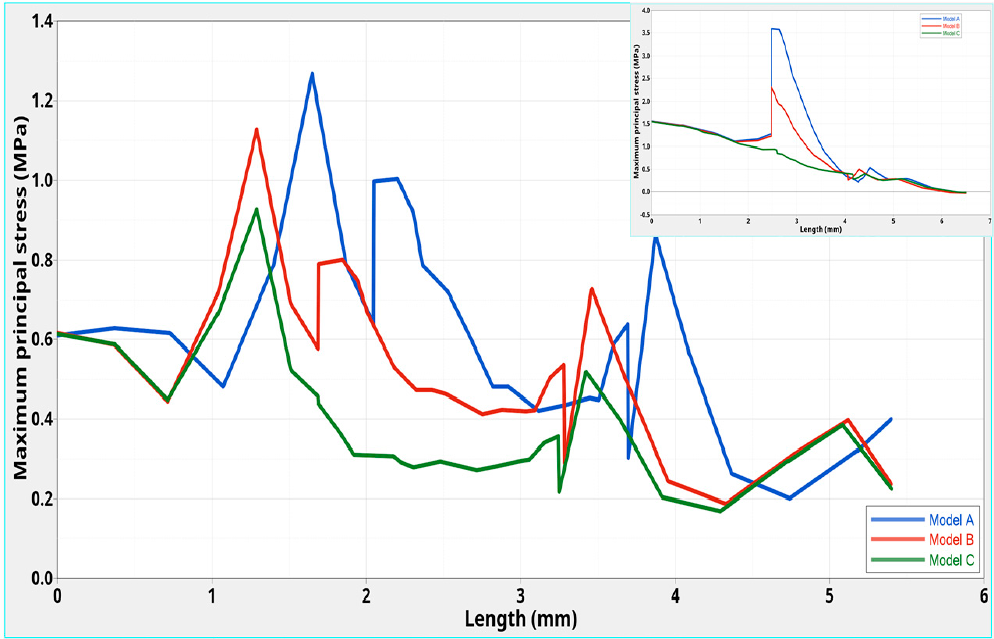
Figure 8. Maximum principal stress distributions at the interface between the post and tooth: analysis performed at the cervical margin of the tooth and evaluation of stress distribution along the direction indicated by the black line in Figure 7 (upper left). The inset reports the results obtained for corresponding models without a ferrule [12].